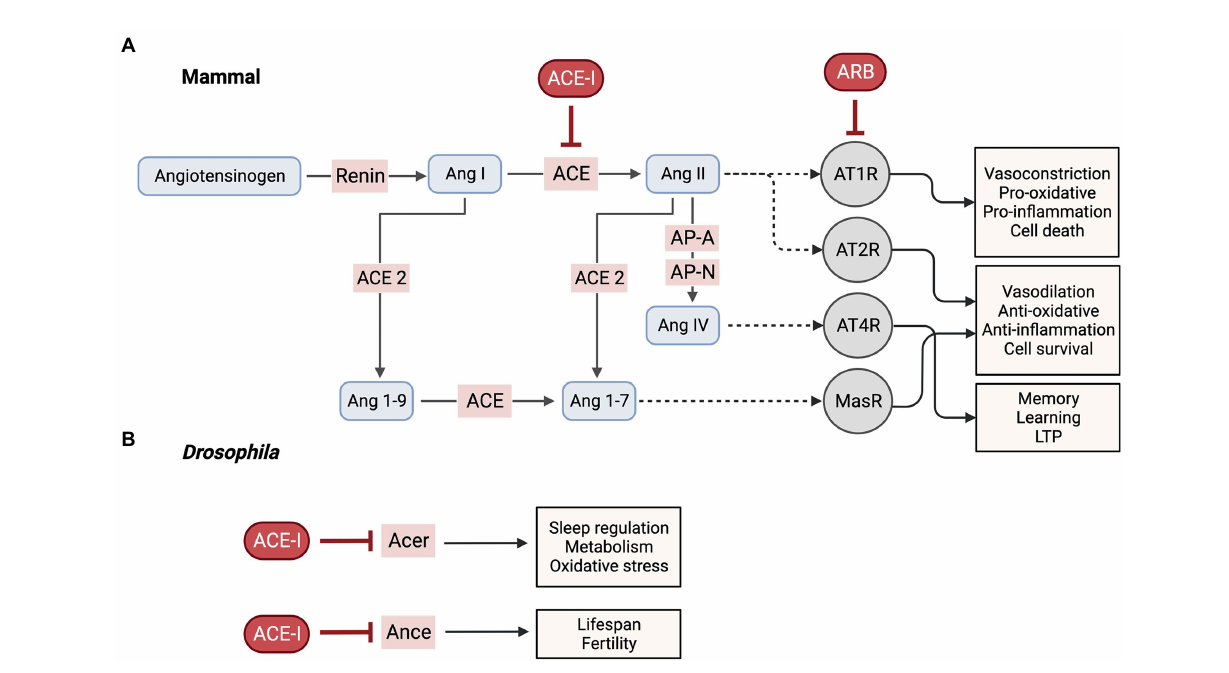
FIGURE 1 RAS in mammals vs. Drosophila . (A) Mammalian brain RAS pathways and its inhibitors. ACE, angiotensin converting enzyme; ACE-I, angiotensin converting enzyme inhibitor; Ang, angiotensin; AP-A, aminopeptidase A; AP-N, aminopeptidase N; ARB, angiotensin receptor blocker; AT1R, angiotensin II type 1 receptor; AT2R, angiotensin II type 2 receptor; AT4R, angiotensin 4 receptor; LTP, long-term potentiation; MasR, Mas receptor. (B) ACE-I inhibit Acer and Ance, the Drosophila ACE homologs. Acer, angiotensin-converting-enzyme related; Ance, angiotensin converting enzyme. (Created with